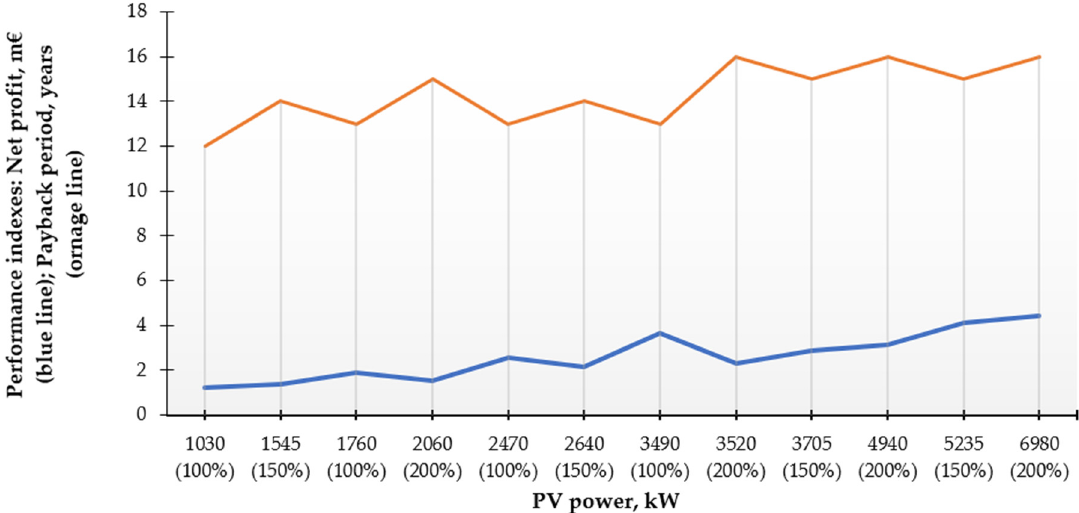
Figure 6. Net profit of prosumers and payback period results of analyzed scenarios for ECom depending on PV installed power. Obviously, the profitability of using PV technologies fluctuates greatly: the payback period for the capital investments of PV equipment varies from 6 to 16 years. Analyzing Figure 6, for ECom prosumers, the payback period is shorter than for individual prosumers. The difference is significant—from 4 to 6 years. The lowest payback period (6 years) and the highest prosumers’ net profit (EUR 6.39 million ) is reached in Scenario 7, when the permitted power of the PV panels equals 2470 kW (100% power). The longest payback period (16 years) and the lowest net profit (EUR 2.29 million ) is received in